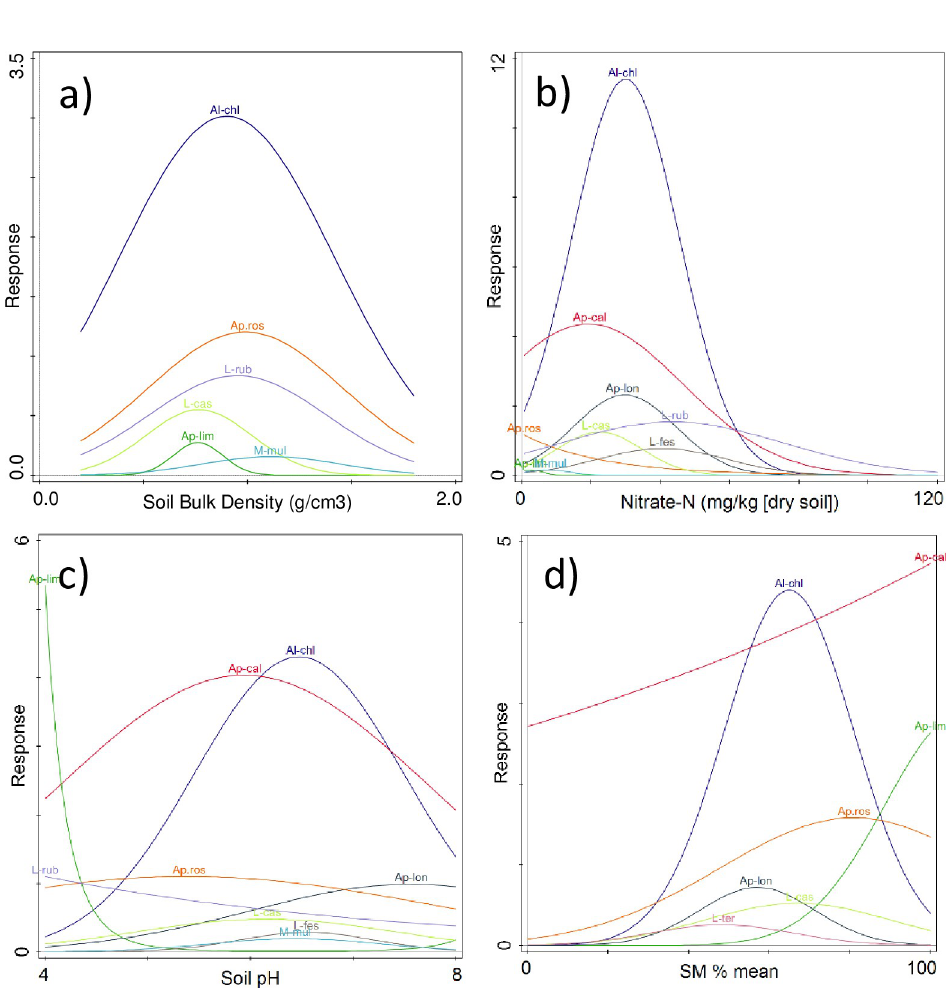
Fig 4. Generalized linear model fits between measured soil parameters and numbers of earthworms at a species level across all sampling sites. a) bulk density, b) nitrate-N, c) pH, d) soil moisture content (SM%). Details of the models including uncertainties are given in S7 Table. Only species where numbers vary with the particular soil parameter are shown. (Al-chl = Allolobophora chlorotica , A pros = Aporrectodea rosea, L-rub = Lumbricus rubellus , L- cas = Lumbricus castaneus , Ap-lim = Aporrectodea limicola , Ap-cal = Aporrectodea caliginosa , Ap-lon = Aporrectodea longa , M-mul = Murchieona muldall , L-fes = Lumbricus festivus , L-ter = Lumbricus terrestris .